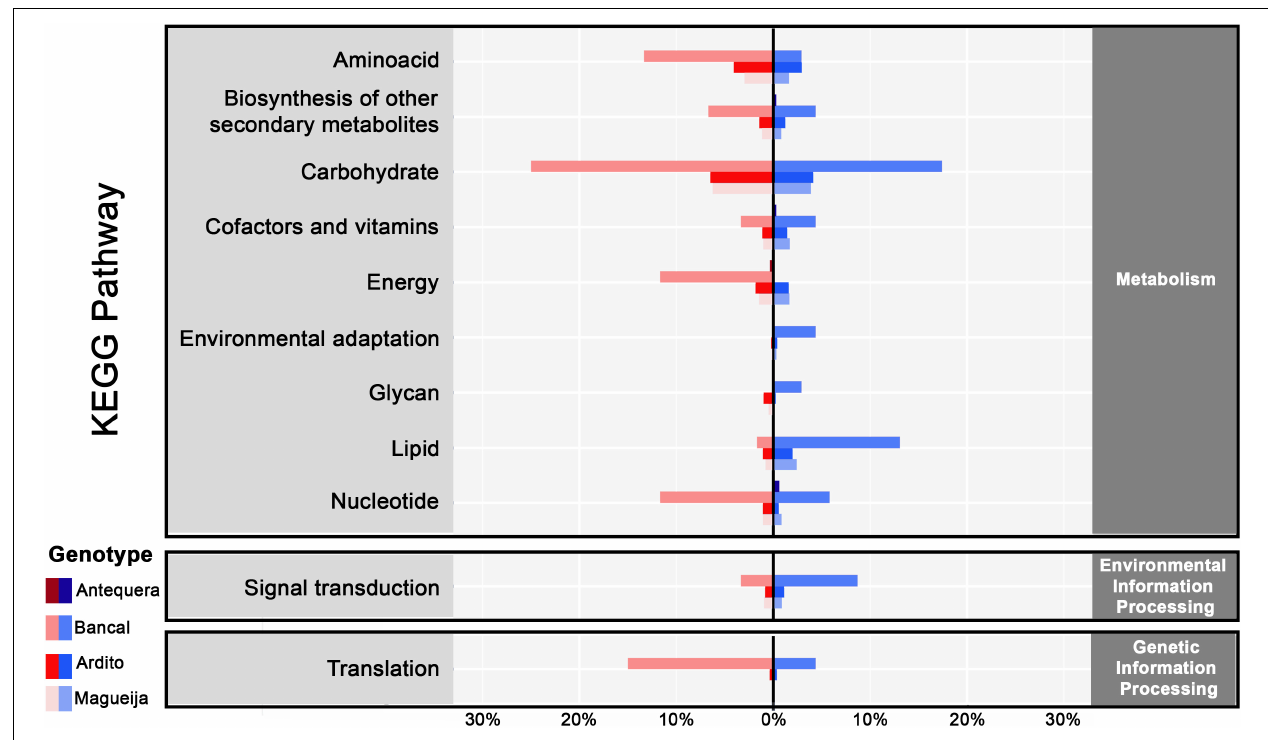
FIGURE 4 | KEGG pathways enrichment percentage of up and downregulated genes in commercial varieties Antequera and Bancal and landraces Ardito and Magueija associated with metabolic, environmental and genetic information processing pathways. Red and blue indicate down and upregulated genes,